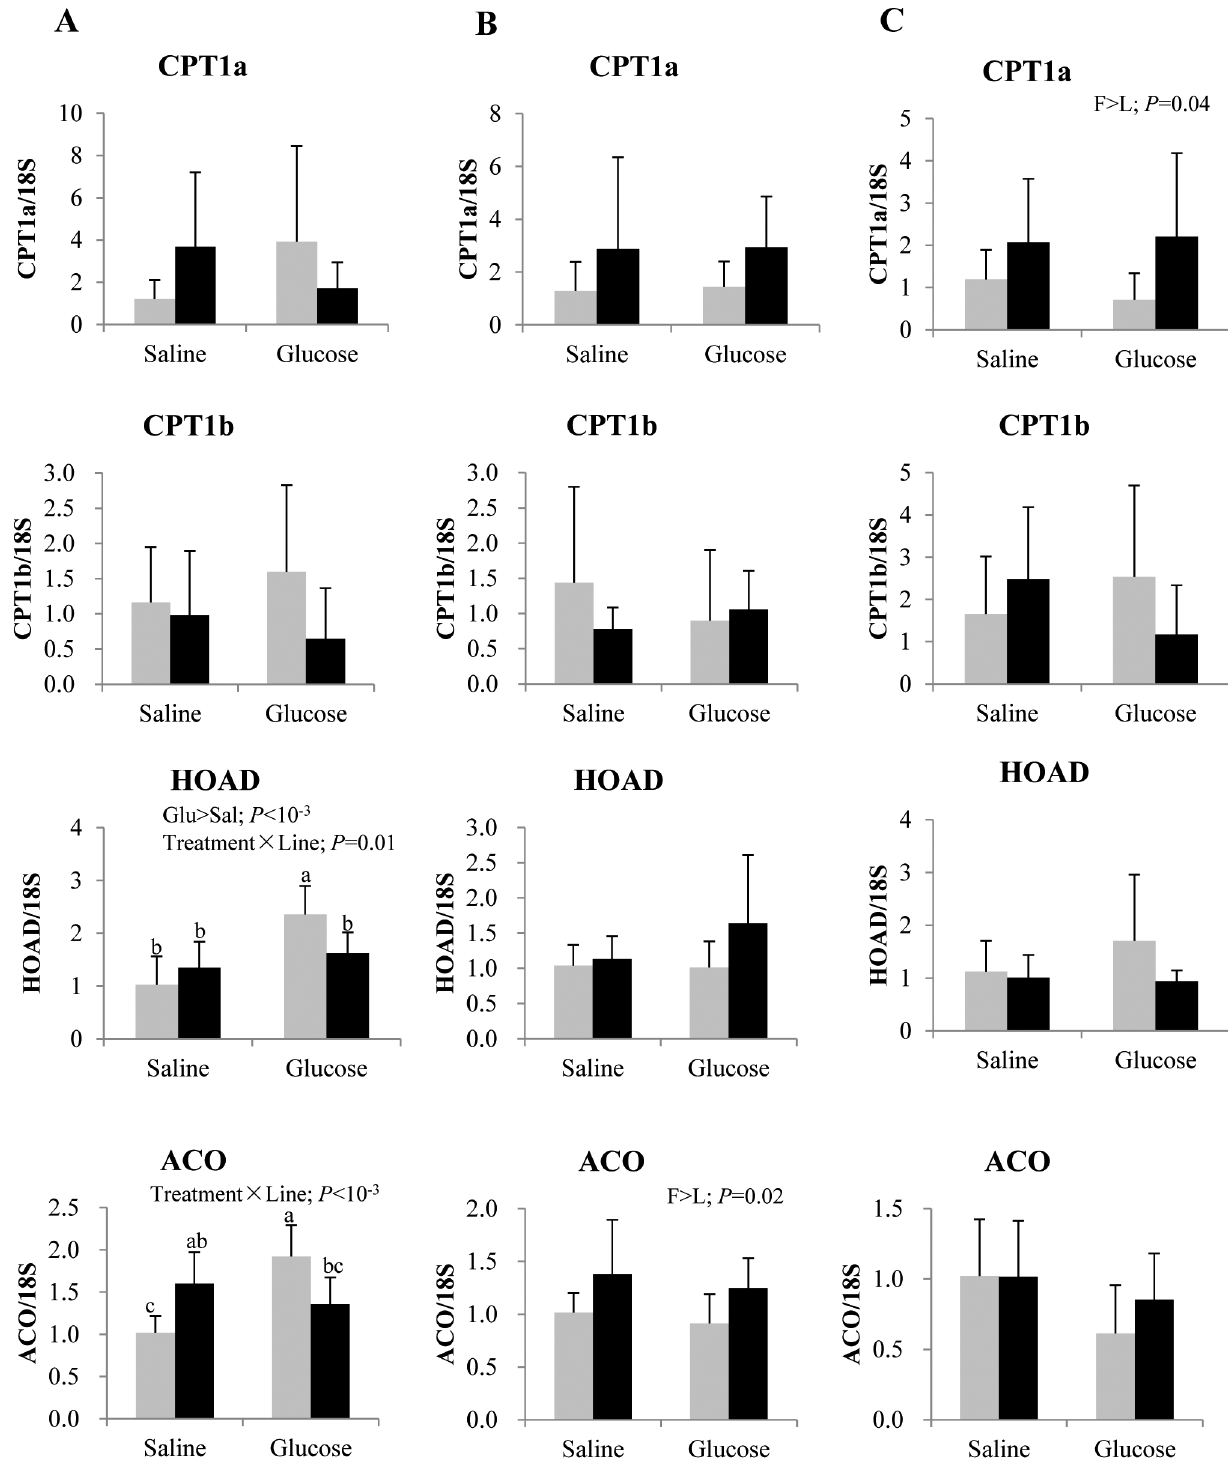
Figure 7. Gene expression of selected fatty acid oxidation enzymes in the liver of rainbow trout from L line (L; grey bars) and F line (F; black bars) at 3 h (A), 8 h (B) and 12 h (C) after IP administration of glucose or saline solution. Carnitine palmitoyl transferase isoform 1 a (CPT1a) and b (CPT1b), 3-hydroxyacyl-CoA dehydrogenase (HOAD) and acyl-CoA oxidase (ACO) mRNA levels were measured using real-time quantitative RT-PCR. Expression values were normalized by 18S-ribosomal RNA transcripts. Results are expressed as means 6 SD ( n =6) and were analyzed using two-way ANOVA ( P , 0.05), followed by a Student-Newman-Keuls multiple comparison test. Mean values not sharing a common lowercase letter are significantly different from each other.